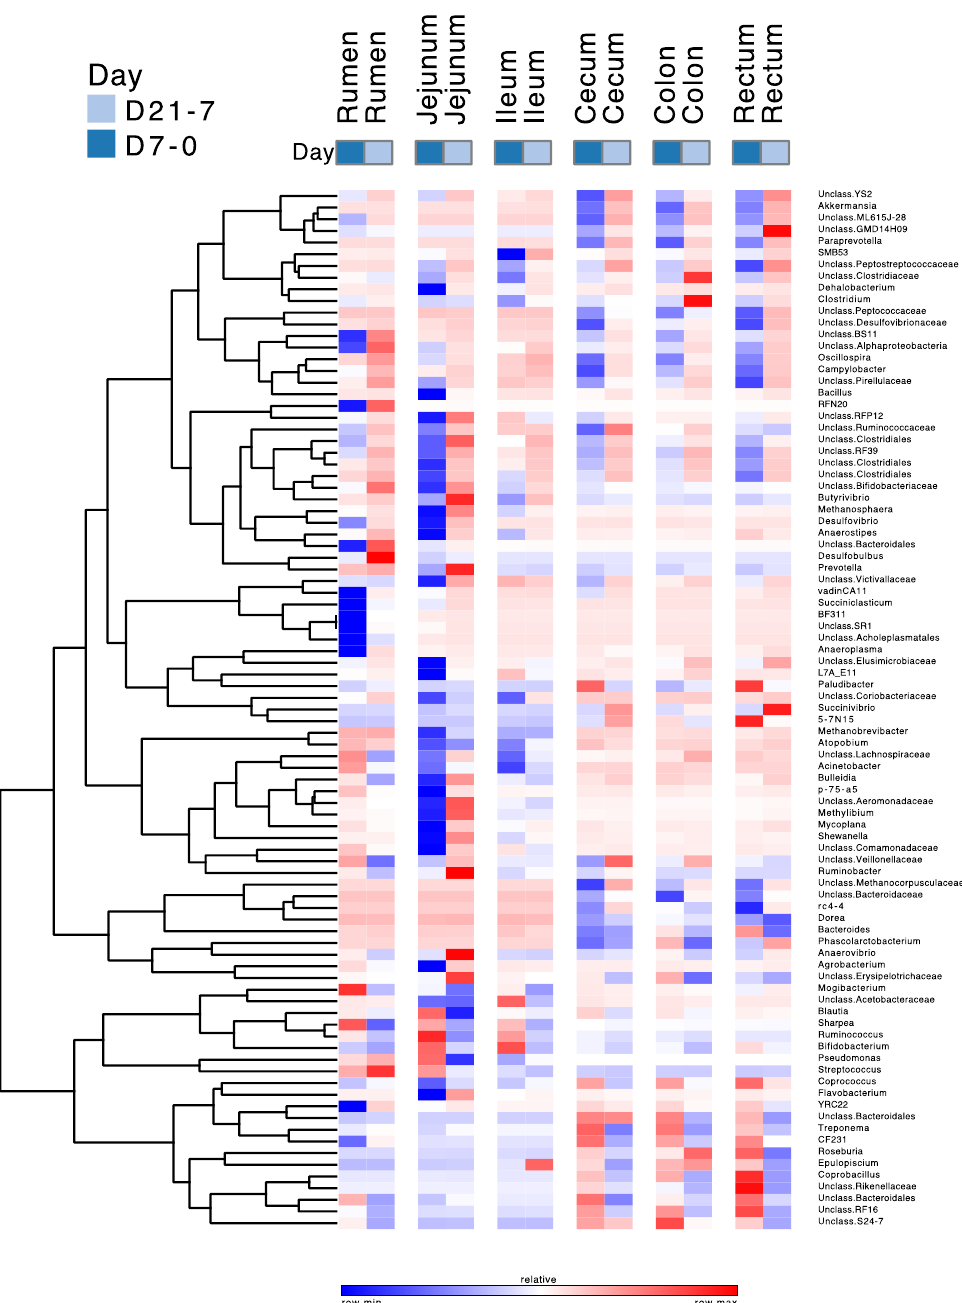
Figure 8. Pattern of change of the relative abundances of abundant genera due to the duration of moderate grain feeding. The magnitude of change varies among lines. D7-0 = 7 d grain feeding vs. no grain feeding; D21-7 = 21 d grain feeding vs. 7 d grain feeding. The scale of the changes varies among rows.